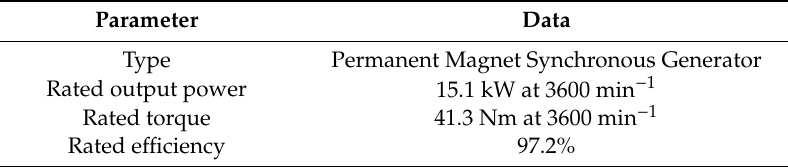
Table 2. Specifications of the KOMEL PMGgi132M4C electric generator.